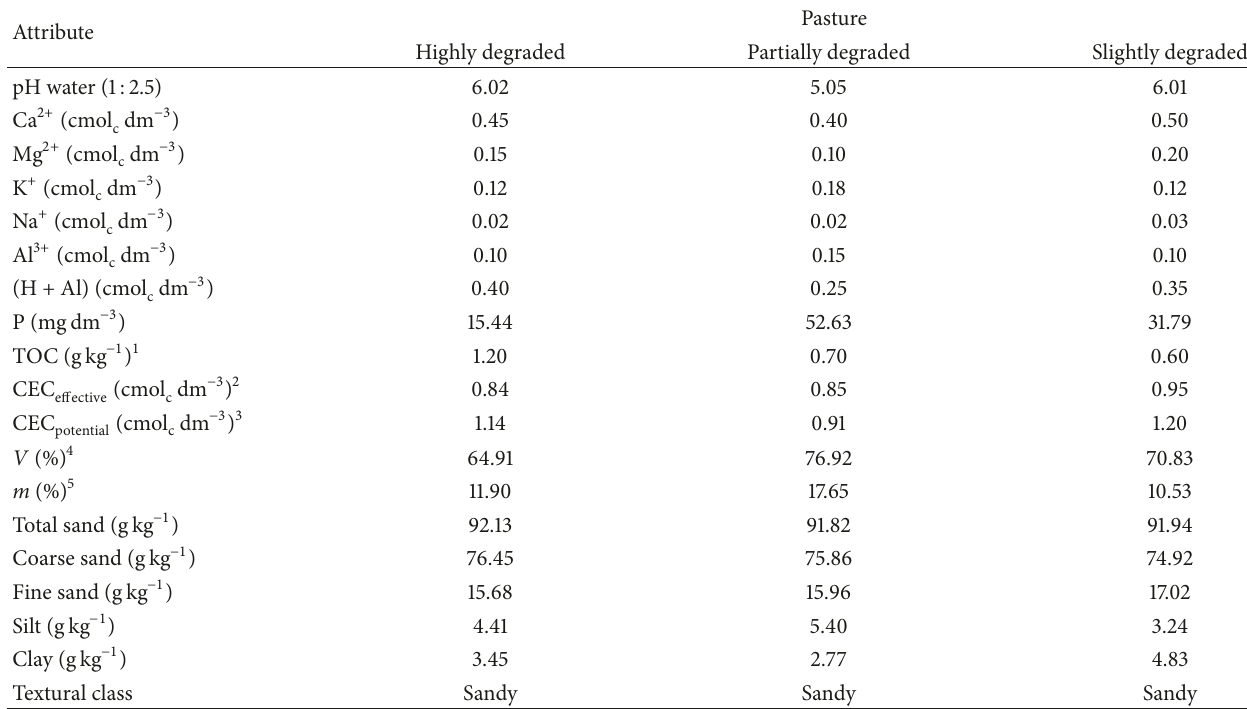
Table 1: Soil chemical and physical attributes in the layer of 0.0–0.2 m of pastures cultivated in different degradation stages for the collection of plant and rhizospheric soil samples to characterize the diazotrophic bacterial community. Pasture Attribute Highly degraded Partially degraded Slightly degraded pH water (1:2.5)